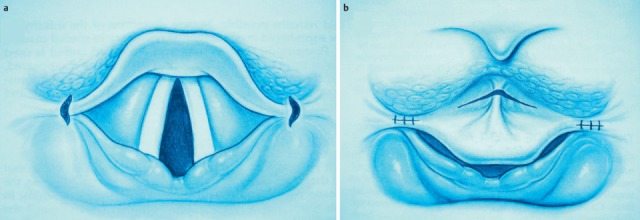
a – for epiglottic lowering, the plicae can be elongated or transected; b – after transection and suturing of the plicae pharyngoepiglotticae, an additional stepwise disconnection of the plica glossoepiglottica is possible.